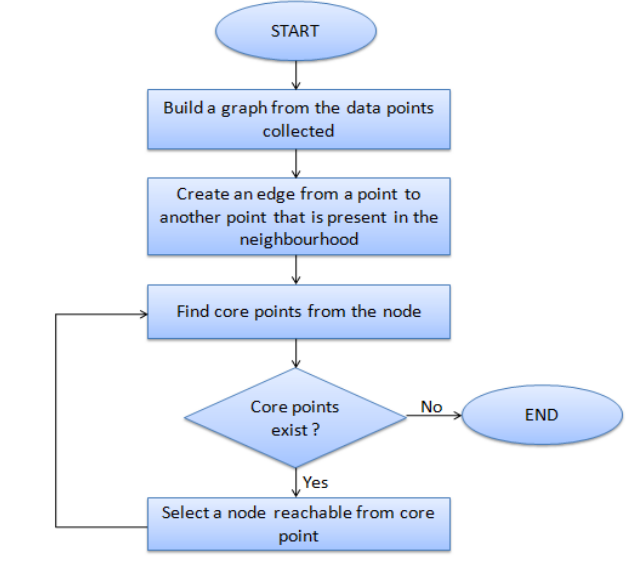
Fig. 14. DBSCAN algorithm.